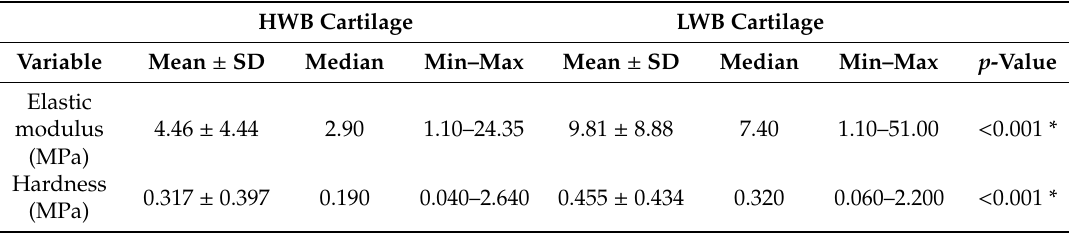
Table 2. Elastic modulus and hardness of high weight bearing (HWB) and low weight bearing (LWB) articular